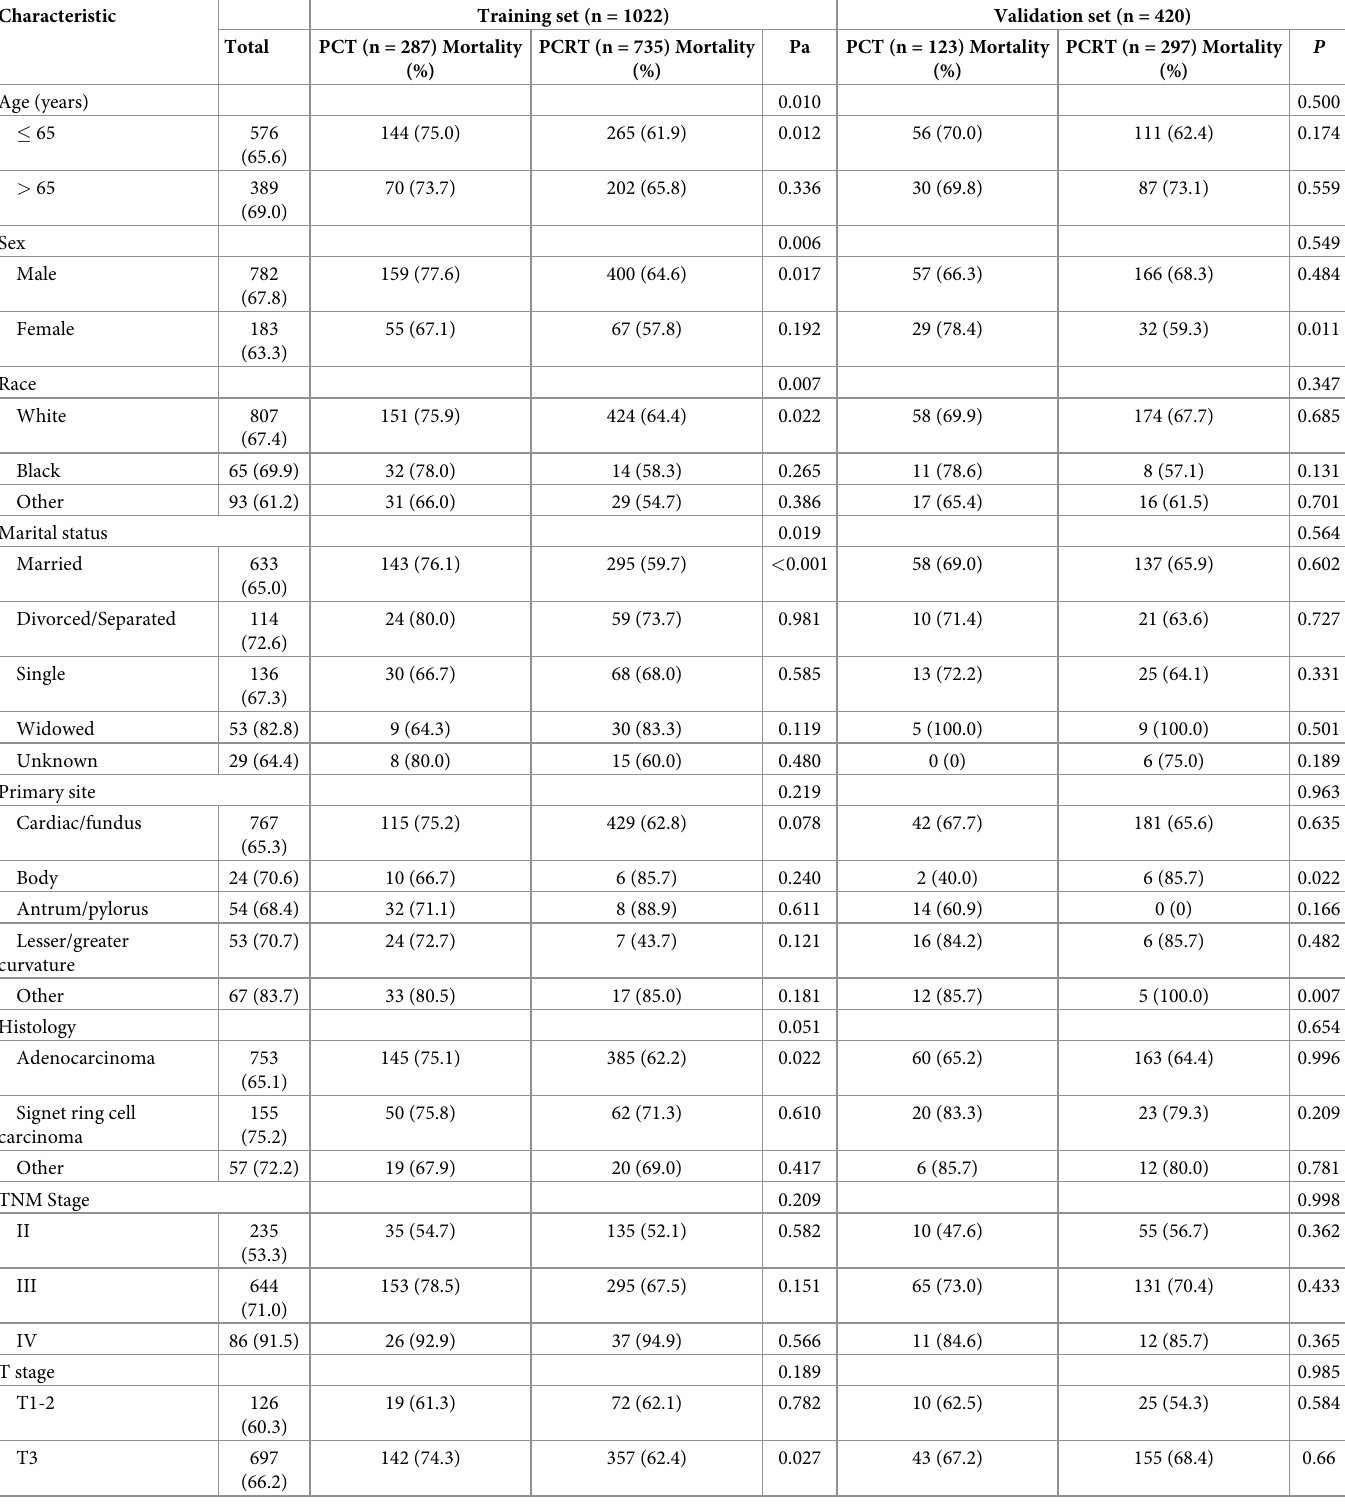
Table 1. Univariate analysis of factors associated with the use of perioperative chemotherapy and perioperative chemoradiotherapy (n = 1442).